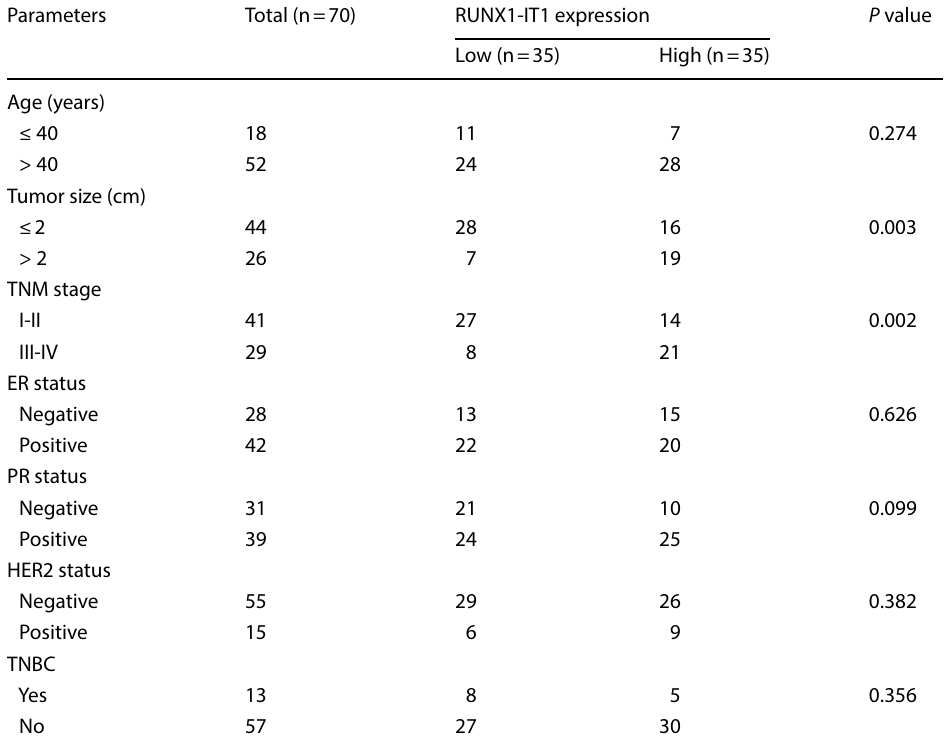
LN lymph node; ER estrogen receptor, PR progesterone receptor, HER2 human epidermal growth factor receptor 2 ; TNBC triple-negative